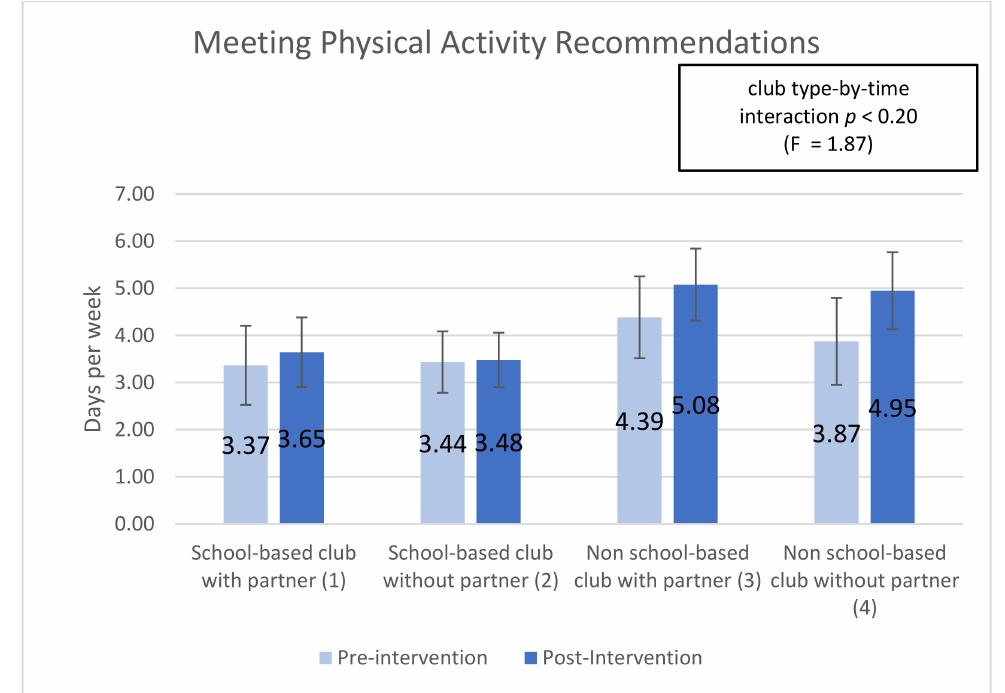
Figure 4. Meeting Physical Activity Recommendations pre- post-assessments by club type and